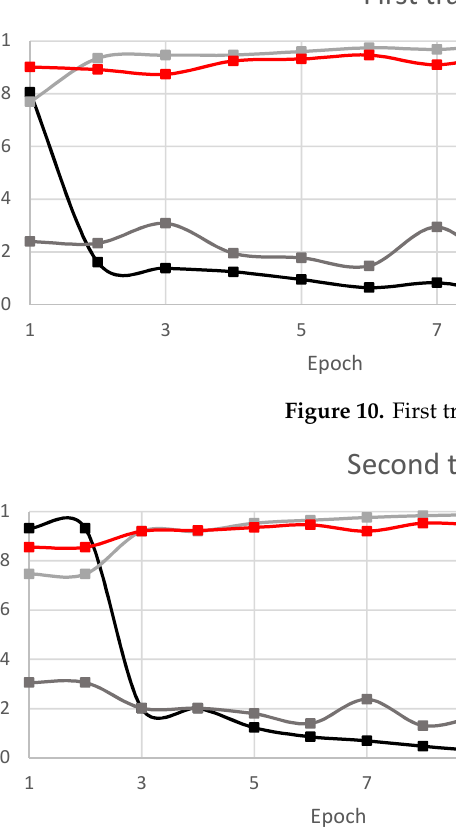
Figure 11. Second training run process.